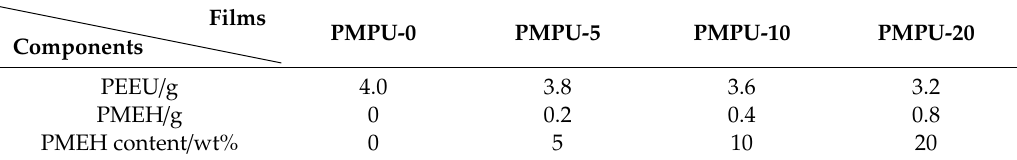
Table 1. The chemical composition of PEEU / PMEH (PMPU)